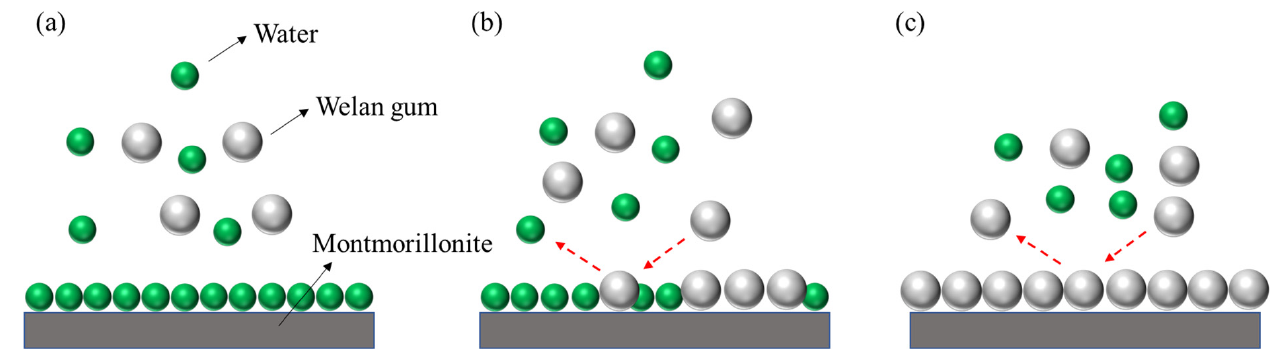
Figure 6. Schematic diagram of the adsorption process and mechanism of welan gum on montmo- rillonite. ( a ) Before adsorption; ( b ) during adsorption; ( c ) after adsorption.